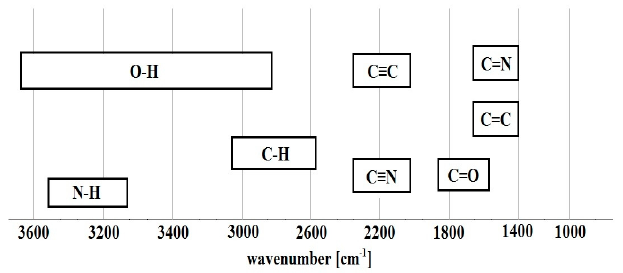
Figure 4. Ranges wave numbers characteristic for selected functional groups of volatile organic compounds.